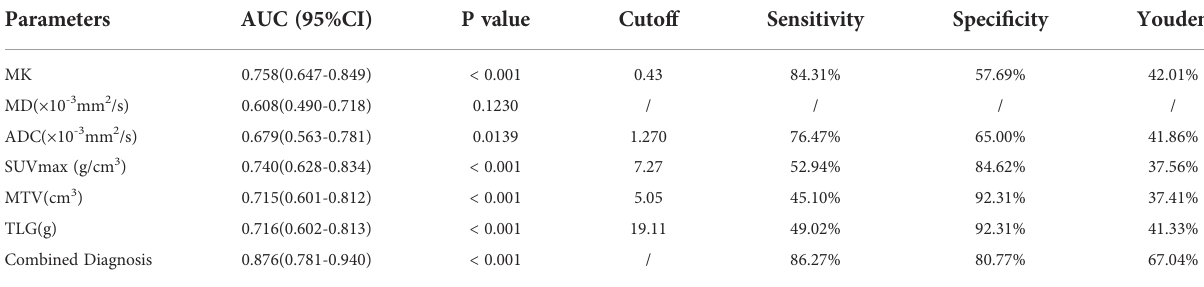
TABLE 5 ROC Analysis of the diagnostic performance for different parameters and methods alone or in combination for differentiating Adenocarcinoma (AC) from Squamous Cell Carcinoma (SCC).